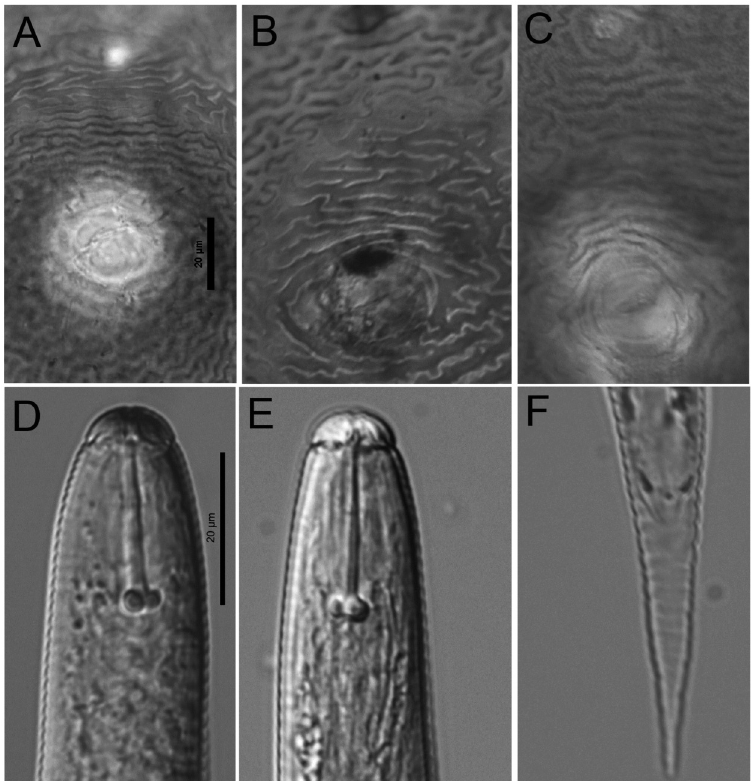
Figure 1. Morphology of a Globodera pallida sample from Italy. A, B and C, cyst perineal patterns; D and E, anterior of the second stage juveniles; F, tail of the second stage juvenile. Bar =